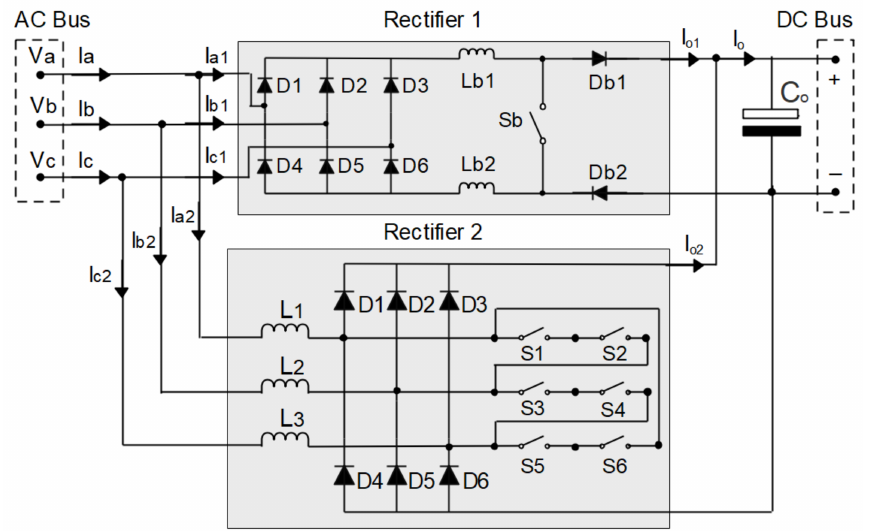
Figure 23. Configuration of the electrical circuit of UHTR-BR1//DR2.